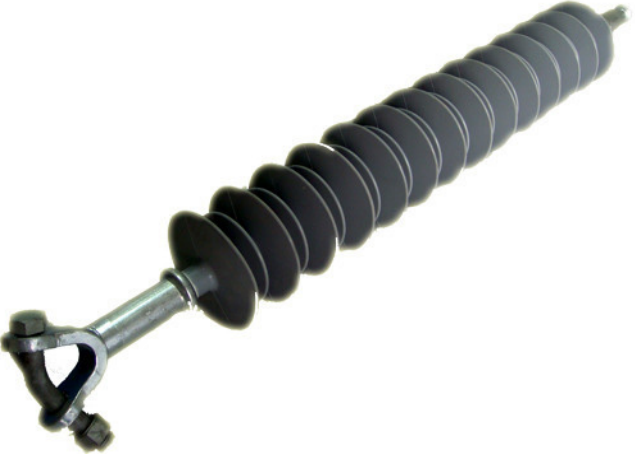
Figure 14. Polymer suspension insulators.